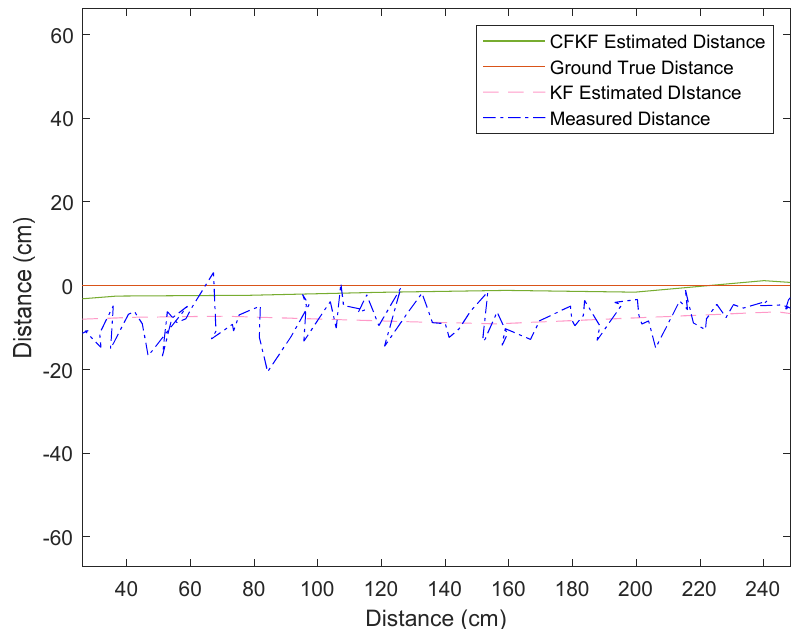
Figure 12. Comparison of different algorithm results in the UWB field experiment.